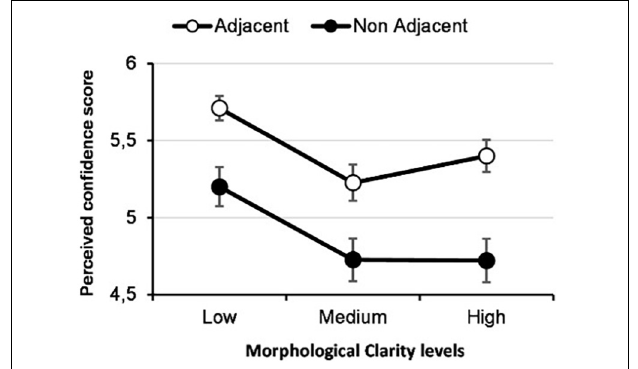
FIGURE 8 | Perceived confidence for each type of